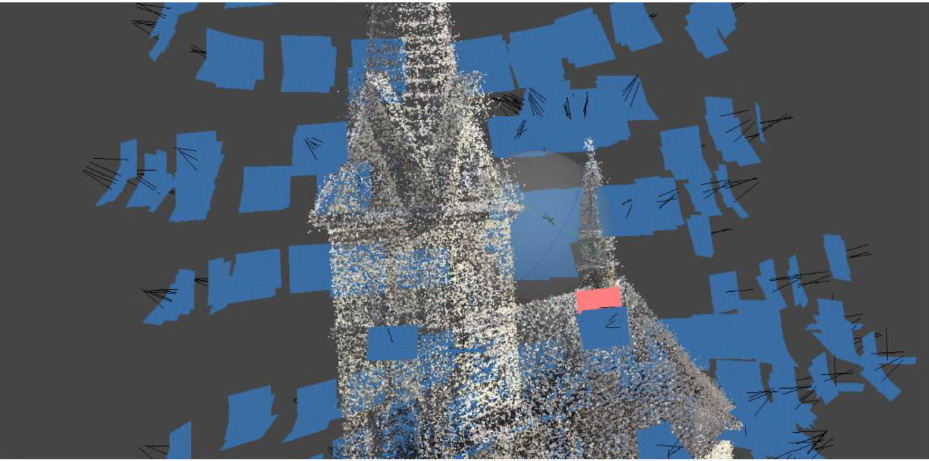
Figure 5. Diagram of the drone